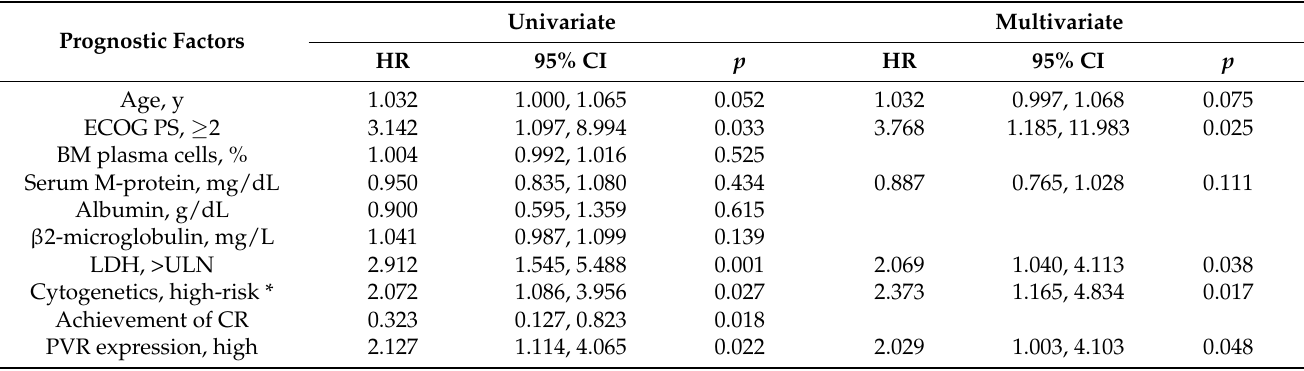
Table 3. Univariate and multivariate analyses for